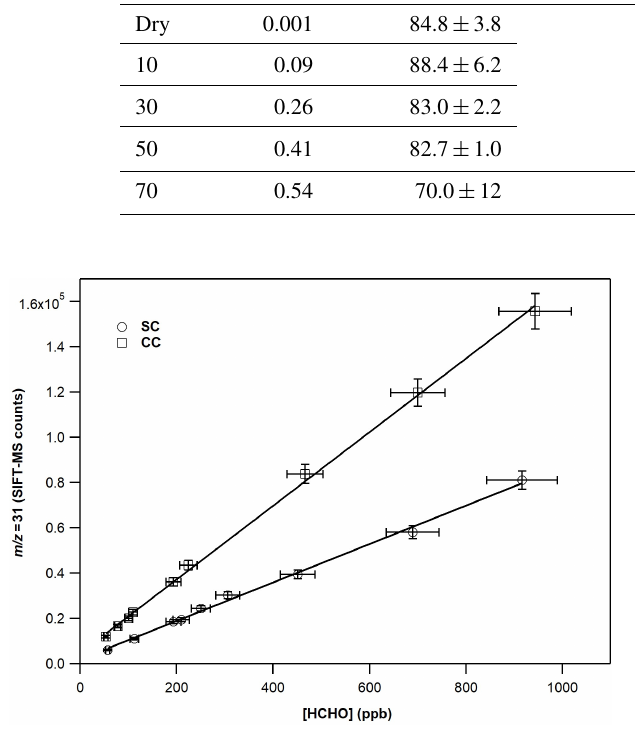
Figure 3. Calibration curves of FM at the m/z 31, derived from the H 3 O + precursor ion under dry conditions. The error bars on the y axis are 5% (extreme value) and correspond to the 2 σ standard deviation of the averaged value of the SIFT-MS signal for each mea- surement. The errors reported on the x axis are 8% and correspond to the uncertainty given for the cross section value of FM (4%) and other systematic uncertainties (in the flow of the mixture, sampling flow of the instrument, etc.) added in